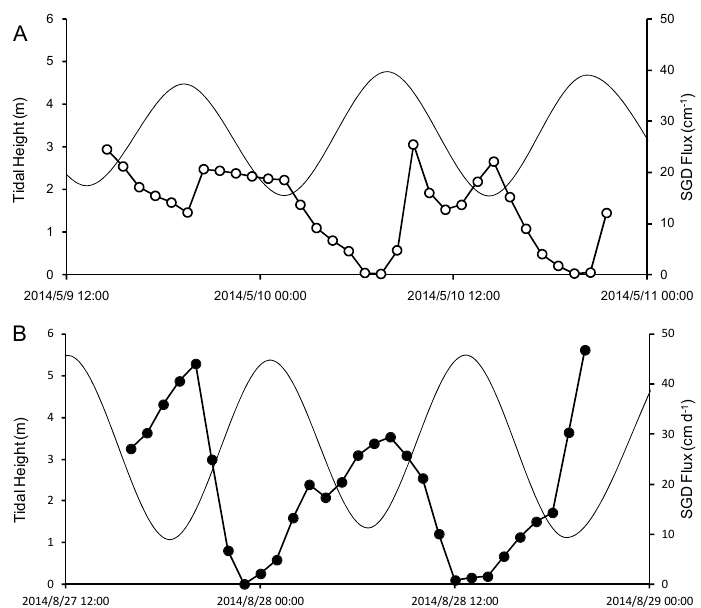
Figure 8. The plots show the results of SGD flux into the Gaomei Wetland over the experimental periods ( A ) 2014/05/09 14:30~2014/5/10 21:30, dry season; ( B ) 2014/08/27 16:00~2014/08/28 20:00, wet season, based on an 222 Rn mass balance model with a 222 Rn concentration of 9187 (Bq m − 3 ) as the groundwater end-member value. The estimated SGD flux fluctuated with tide, showing higher flux at low tide but a lower one at high tide. Table 3. The estimated submarine groundwater discharge (SGD) rates in the Gaomei Wetland through different approaches.